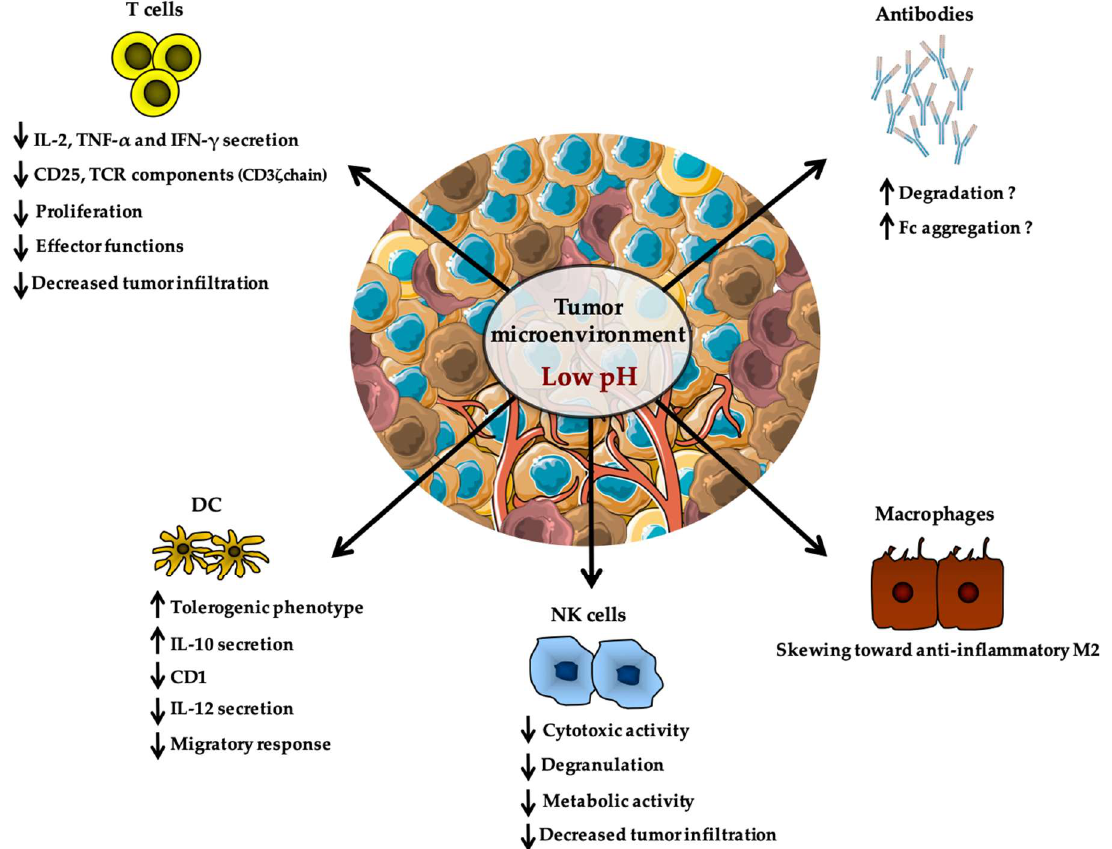
Figure 2. Tumor acidity impacts on immune cell function. As illustrated in the review’s text, tumor acidity acts as an immune escape mechanism by which tumor cells (whose heterogeneity is depicted by tumor cells of different colors) repress the activity of anti-tumor immune effectors (including T cells, natural killer (NK) cells, and dendritic cells (DC)), and also favor the conversion of macrophages toward a non-inflammatory M2 phenotype, potentiated by hypoxia and altered metabolism, thereby creating an hostile milieu for T cells, NK cells, and DC. However, the possible effect of pH on antibody activity is still controversial and not fully elucidated. IL-2: Interleukine 2, TNF-α: Tumor necrosis factor-α, IFN-γ: Interferon gamma, TCR: T cell receptor, IL-12: Interleukine 12, IL-10: Interleukine 10, DC: Dendritic cell, NK: Natural killer, Fc: Fragment crystallizable.